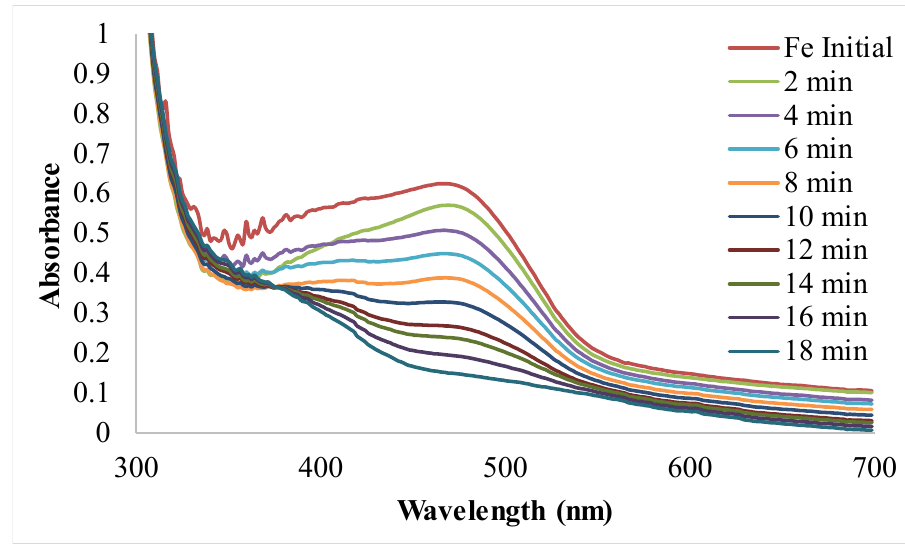
Figure 7. UV-visible spectra for photocatalytic degradation of MO using Fe NPs. Photocatalytic degradation potential of Mn NPs was also tested against MO dye. Degradation of MO dye was carried out in the presence of nanocatalyst i.e., Mn NPs. Spec- tra of the dye were recorded after regular time intervals in the presence of the catalyst (Figure 8). Results revealed that degradation of MO dye was achieved up to 80% within 20 min. For the degradation of dye, Fe NPs were found better as compare to Mn NPs.